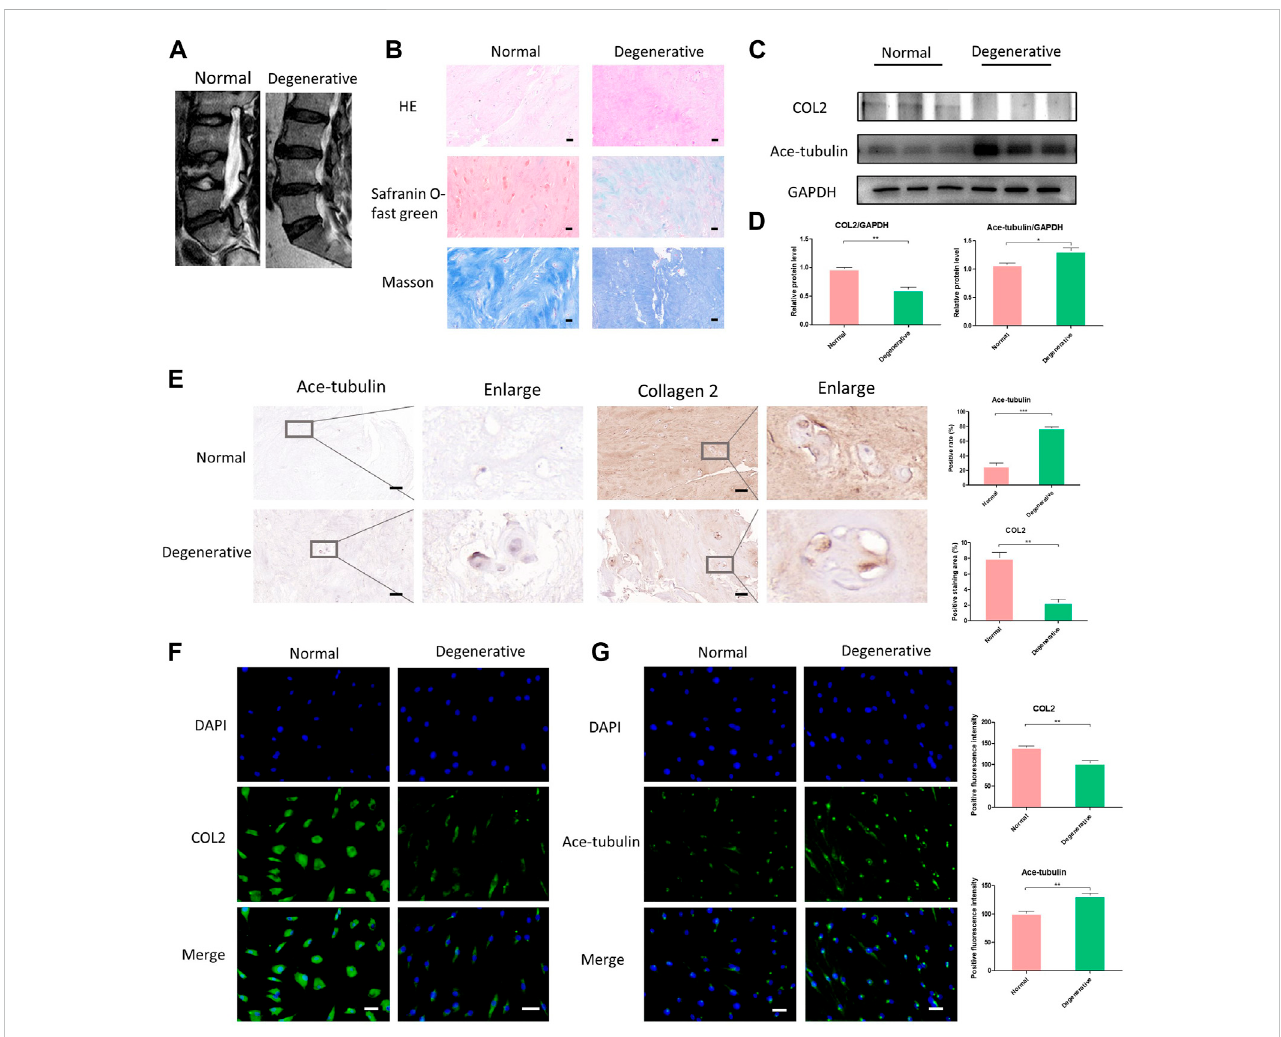
FIGURE 1 The differential expression of Ace-tubulin and type Ⅱ collagen (COL2) in human degenerated nucleus pulposus (NP) cells and normal NP cells. (A) T2weightedimagingofhumandegenerativeandnormalintervertebraldiscs. (B) TheHEstaining,safraninO-fastgreenstainingandMassonstainingofhuman degenerated and normal nucleus pulposus tissues. (C, E) Western blot analysis and immunohistochemical staining of human degenerative and normal nucleuspulposustissues. (D) Quanti fi cationofthedataof (C) . n =4. (F,G) Cellimmuno fl uorescencestainingofhumandegeneratedandnormalNPcells, Scale bar, 100 μ m. Data are represented as the mean ± SEM. * p < 0.05, ** p < 0.01, *** p <